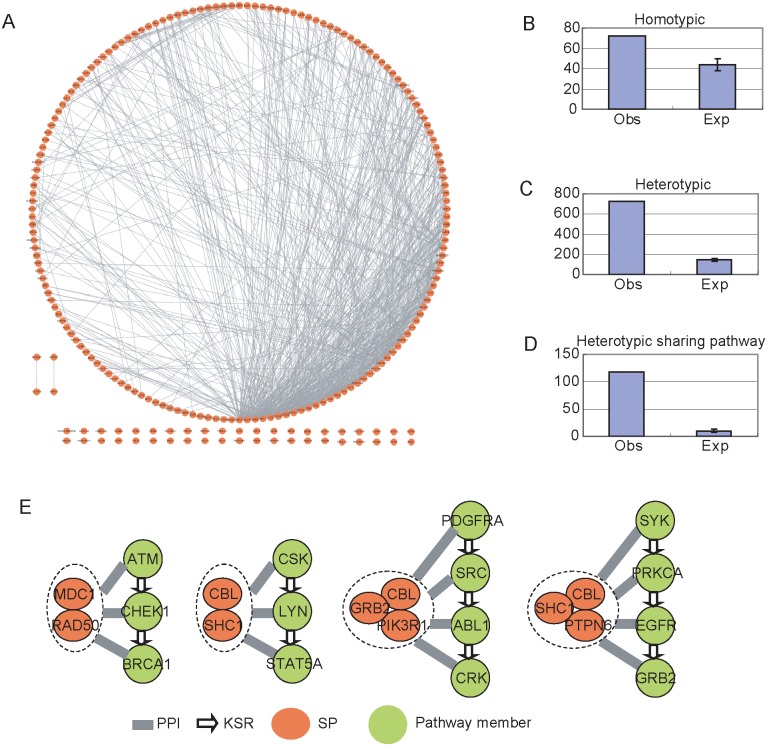
Interactions between scaffold proteins.(A) Overall PPI interaction networks between scaffold proteins. (B) Number of homotypic interactions among scaffold proteins. (C) Number of heterotypic interactions among scaffold proteins. (D) Number of heterotypic interactions that are associated with the same pathways. (E) Examples of scaffold protein complexes that are associated with signaling pathways. The scaffold proteins in a complex interact each other, and all of them interact with each member in the associated pathway.